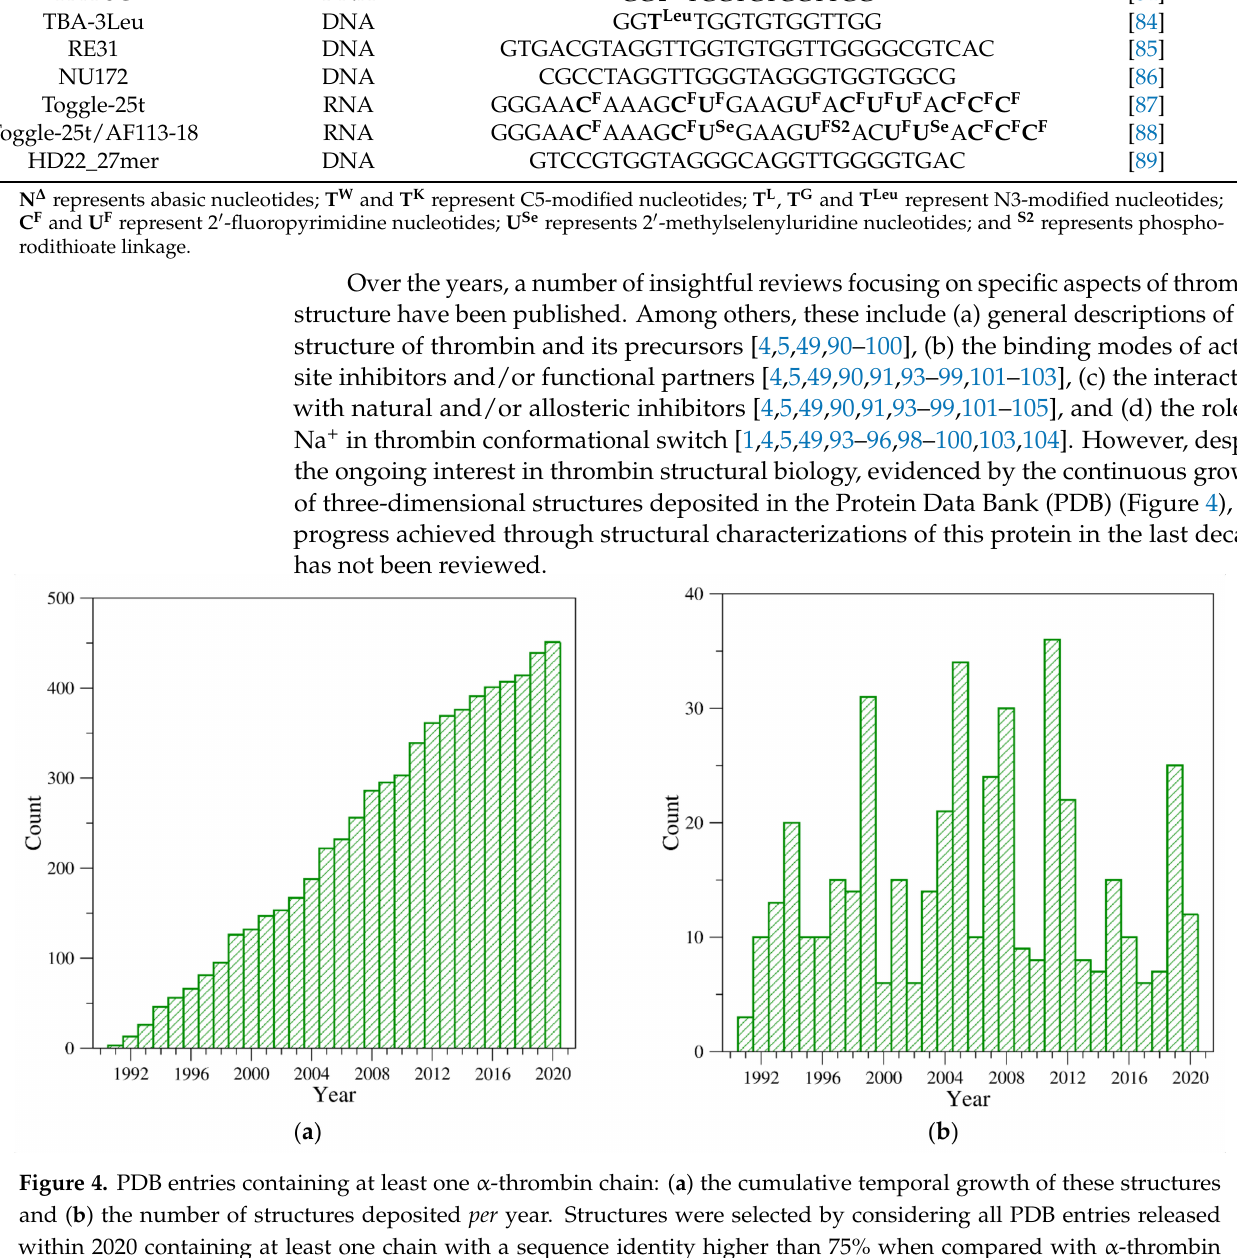
N ∆ represents abasic nucleotides; T W and T K represent C5-modified nucleotides; T L , T G and T Leu represent N3-modified nucleotides; C F and U F represent 2 (cid:48) -fluoropyrimidine nucleotides; U Se represents 2 (cid:48) -methylselenyluridine nucleotides; and S2 represents phospho- rodithioate linkage.